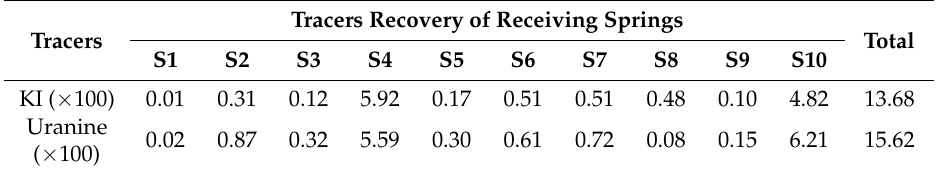
Table 5. Tracer recovery rate (%) for every receiving